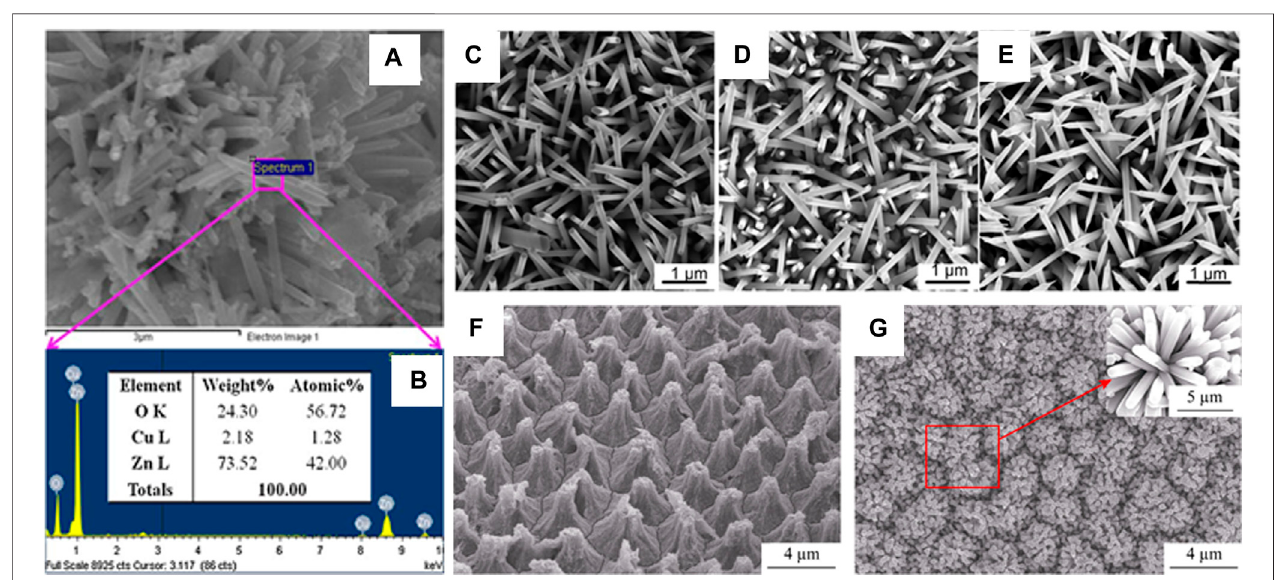
FIGURE 12 | (A,B) Elemental analysis by XEDS of doped CuO-ZnO nanorods (Rahman and Asiri, 2015).; The SEM of Na-doped ZnO nanorods with doping concentrations. (C) 0% (D) 0.5 at. % (E) 2.1 at.% (Ye et al., 2017); SEM images of a PSP ( F ) and ( G ) Mn-doped ZnO/PSPA (Mn-to-Zn molar ratio of 2.0:100.0) (Wu et al.,